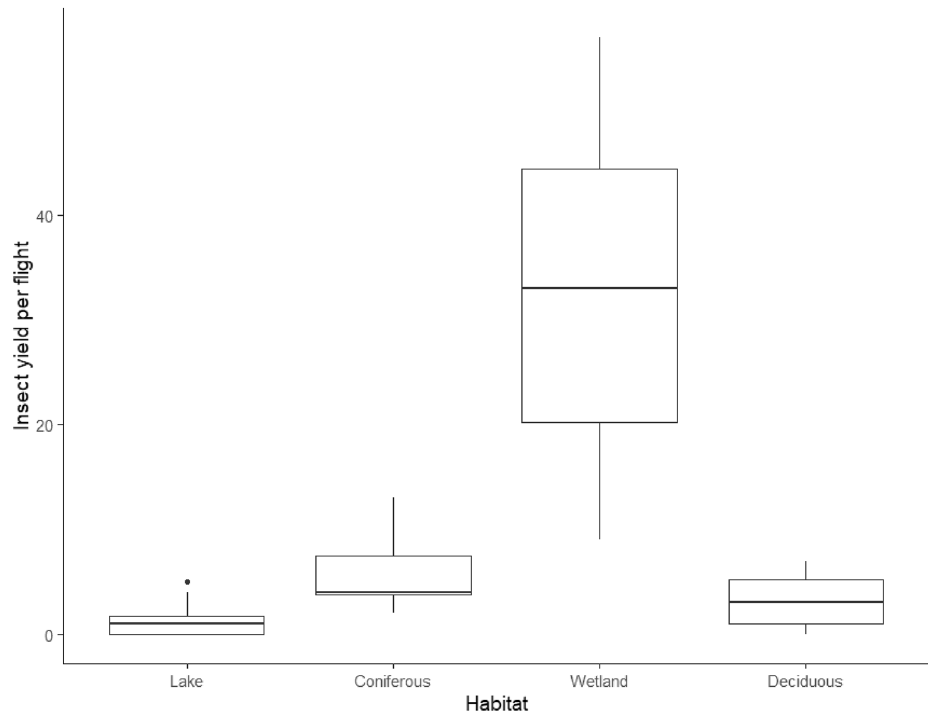
Figure 4. Boxplot of arthropod yield for the four study habitats collected after one 3-min drone flight with canopy contact. Boxes indicate median, first and third quartile, as well as minimum and maximum values.